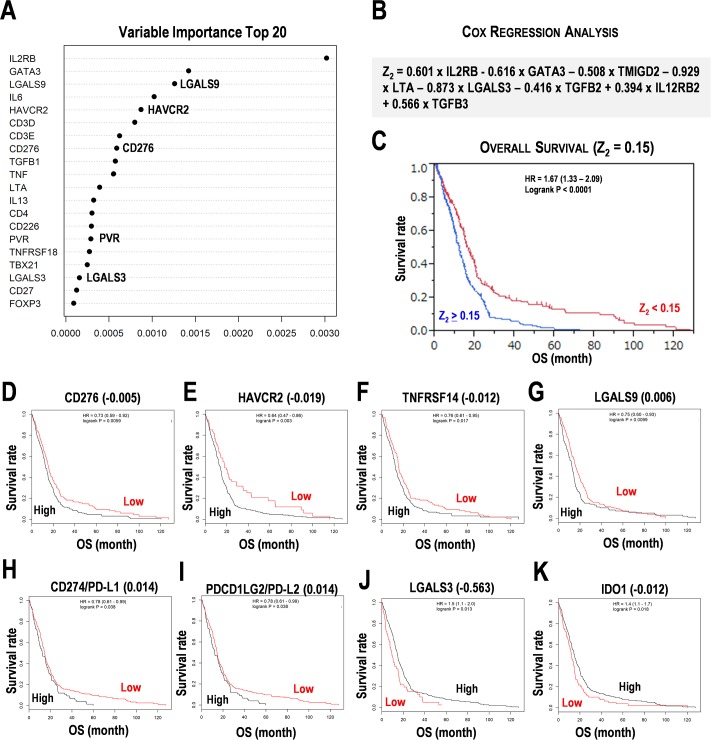
Prognostic marker candidates for cancer immunotherapy in the test data set of glioblastoma multiform (GBM).(A) Random survival forest analysis for cancer immunotherapy-related genes in GBM. Top 20 of variable importance was shown. (B) Prognosis prediction formula for cancer immunotherapy-related genes in GBM. The Z2 score is calculated by the expression values of 8 immunosuppressive pathway genes. (C) Kaplan-Meier survival analysis for overall survival (OS) using the Z2 score = 0.15. HR, hazard ratio. (D-H) Kaplan-Meier survival analysis for representative immunosuppressive pathway genes in GBM. (D) CD276/B7-H3 (E) HAVCR2/TIM-3. (F) TNFRSF14. (G) LGALS9. (H) CD274/PD-L1. (I) PDCD1LG2/PD-L2. (J) LGALS3. (K) IDO1. Numbers in the parentheses indicate the threshold of gene expression. High and low indicate subgroups with over and under the threshold. OS, overall survival. HR, hazard ratio. Subgroups were divided by the median score of Z2 and the median expression of genes.